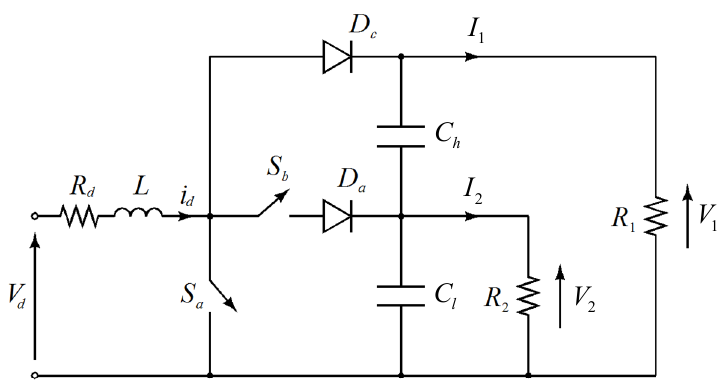
Figure 6. Single inductor double output DC/DC